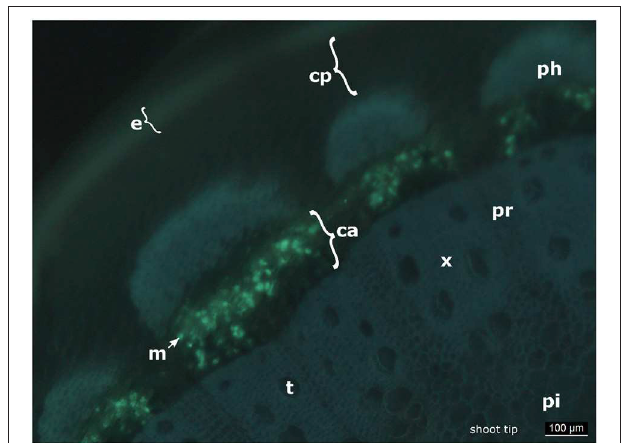
FIGURE 4 | Cross section of an infected shoot tip. The picture shows a cross section of an infected shoot tip from “Pinot blanc” and the presence of the pathogen apparently in the cambium. e, epidermis; cp, cortical parenchyma; ph, phloem; m, mycelium; ca, cambium; x, xylem; pr, pith radiate; pi, pith; t,